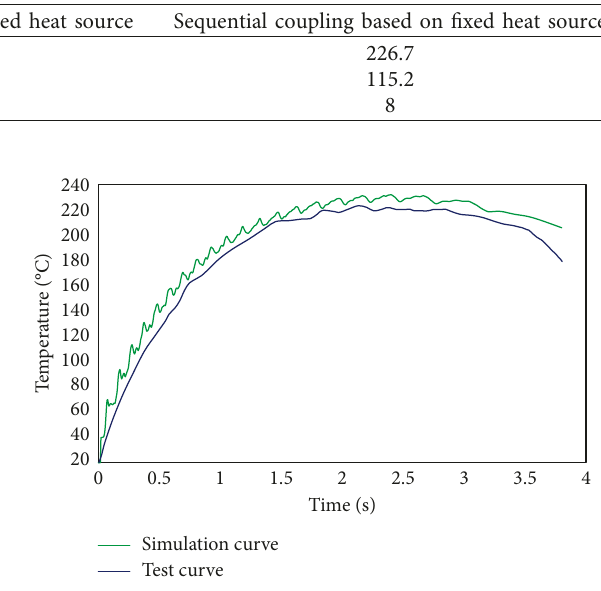
Table 6: Comparison of simulation results and calculation time of three simulation methods.